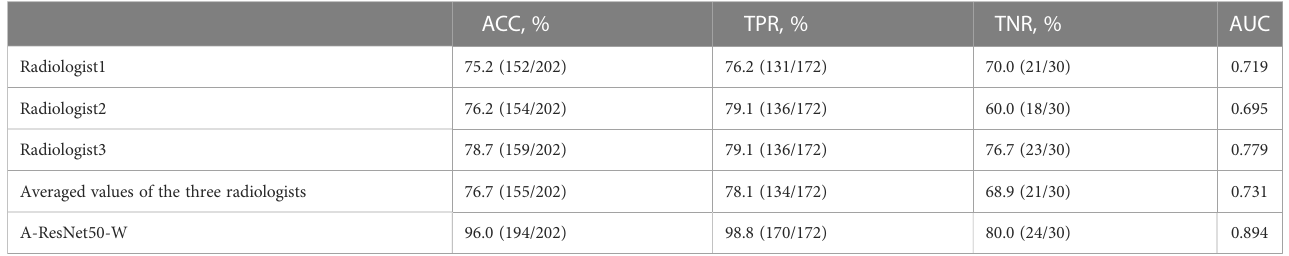
TABLE 5 Classi fi cation performance of the proposed method and three radiologists in the testing set.